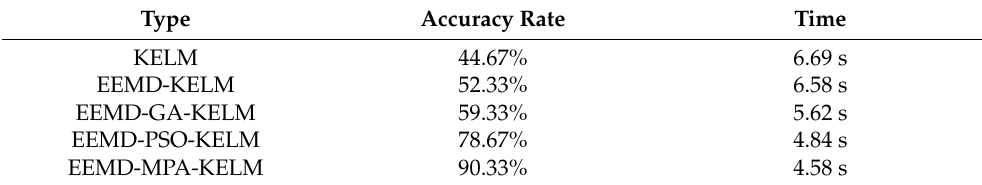
Table 4. Accuracy and running time statistics of each model after 30